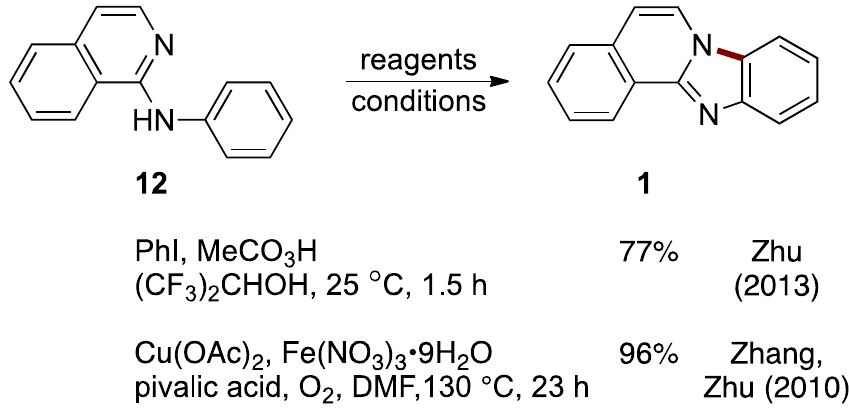
Figure 11. C–H cycloamination of N -phenyl-2-aminoisoquinoline 12 catalyzed by an in situ-generated hypervalent iodine reagent or copper/iron bimetallic system [24,25].